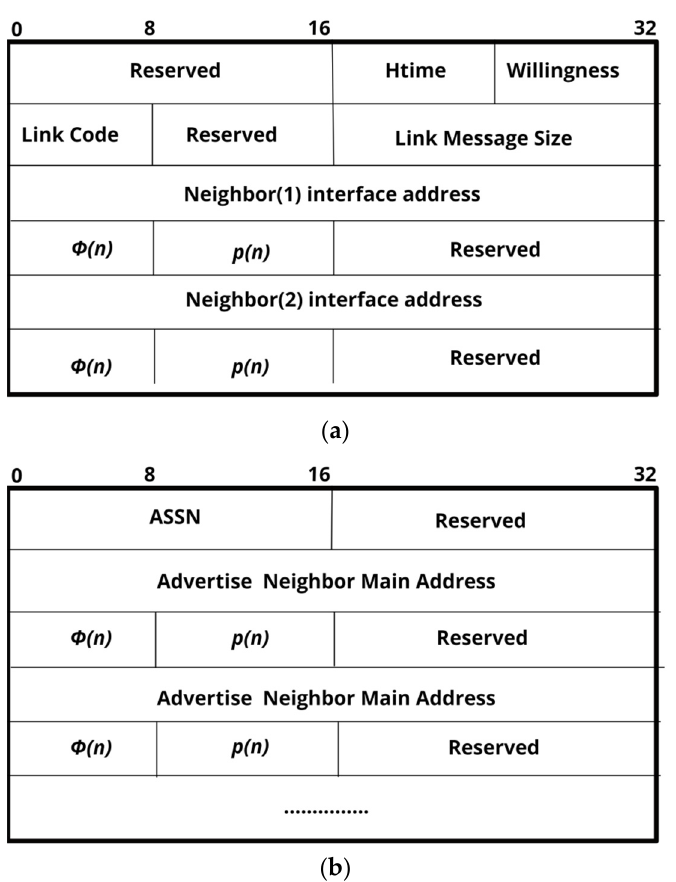
Figure 2. Format of messages for standard OLSR protocols [11]. ( a )“Hello” message. ( b ) Topology control message .